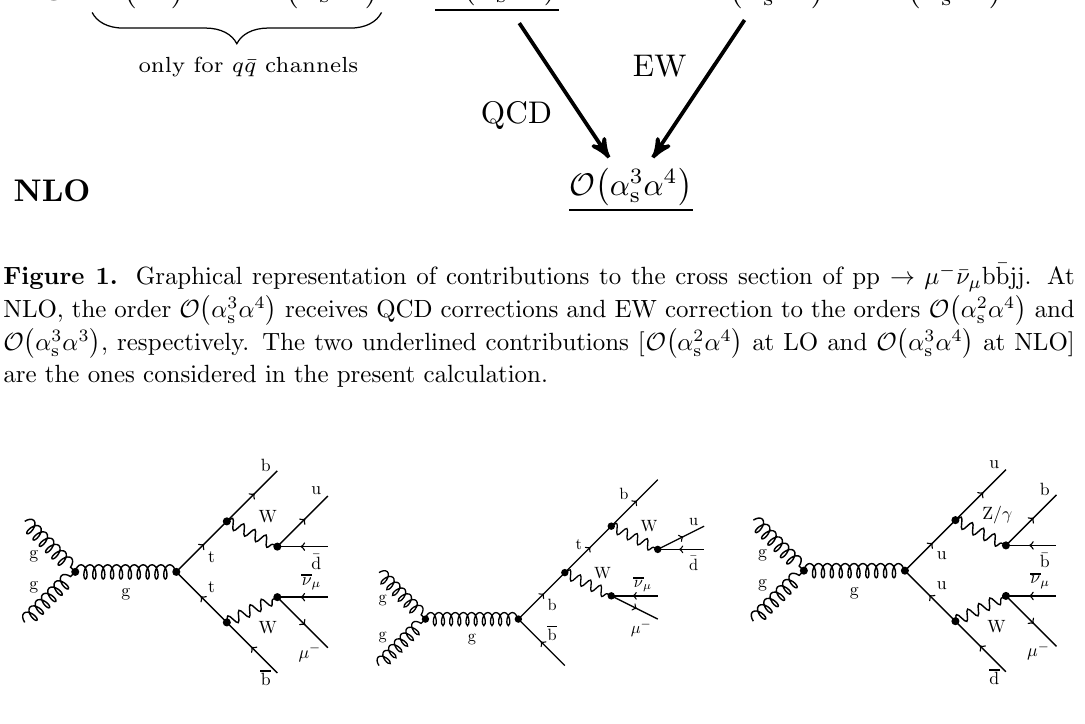
g 2 g 4 for gg (cid:22) (cid:0) (cid:22) (cid:23) (cid:22) b(cid:22)bjj. Some s O ! (cid:0) (cid:1)